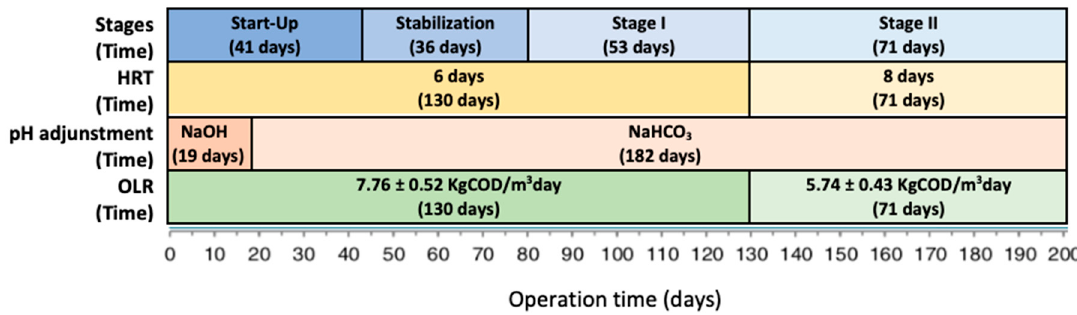
Figure 4. Schematic diagram with the operating conditions of HRT, OLR, and buffers for CWW treatment.